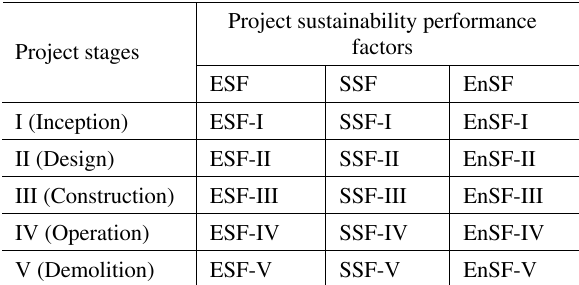
Table 1. Framework of project sustainability